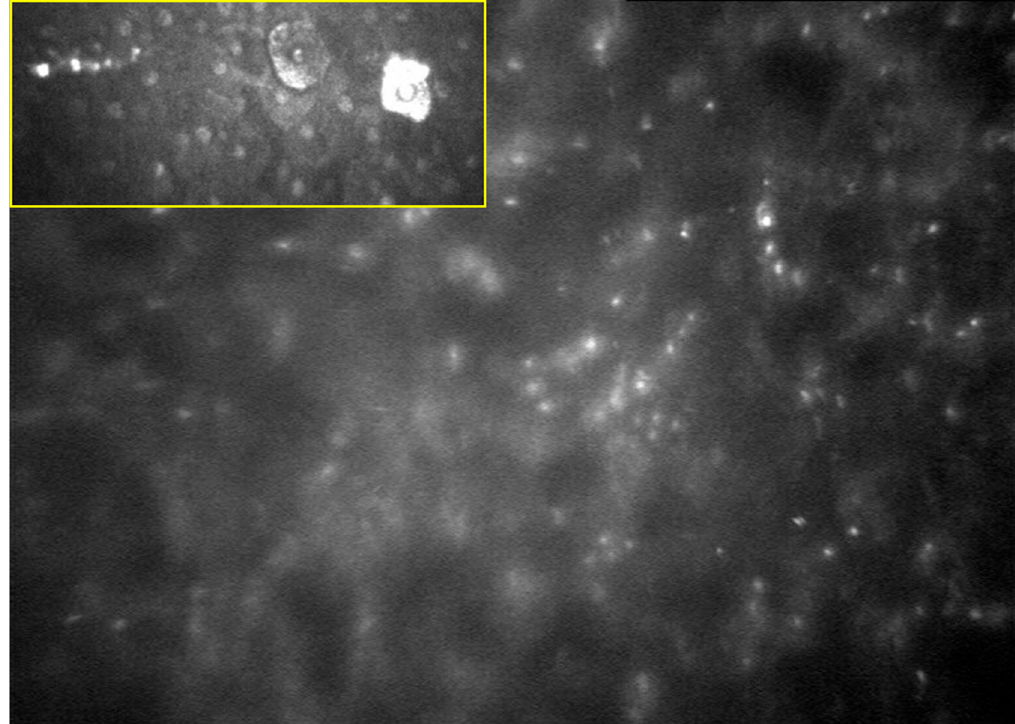
Figure 2. In vivo confocal microscopy image of Acanthamoeba keratitis involving superficial and deeper corneal layers. The typical “starry sky” appearance is depicted: Acanthamoeba spp. cysts appear as oval or round, double-walled, highly refractile structures with a polygonal inner wall and a total size of 12–25 microns [23].